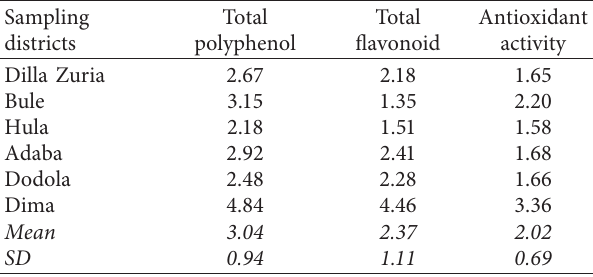
Table 5: The total concentration of polyphenols (mgGAE g − 1 dry sample), flavonoids (mgCE g − 1 dry sample), and antioxidant ac- tivity (mgAAE g − 1 dry sample) determined in the leaves of Urtica simensis collected from six different locations of